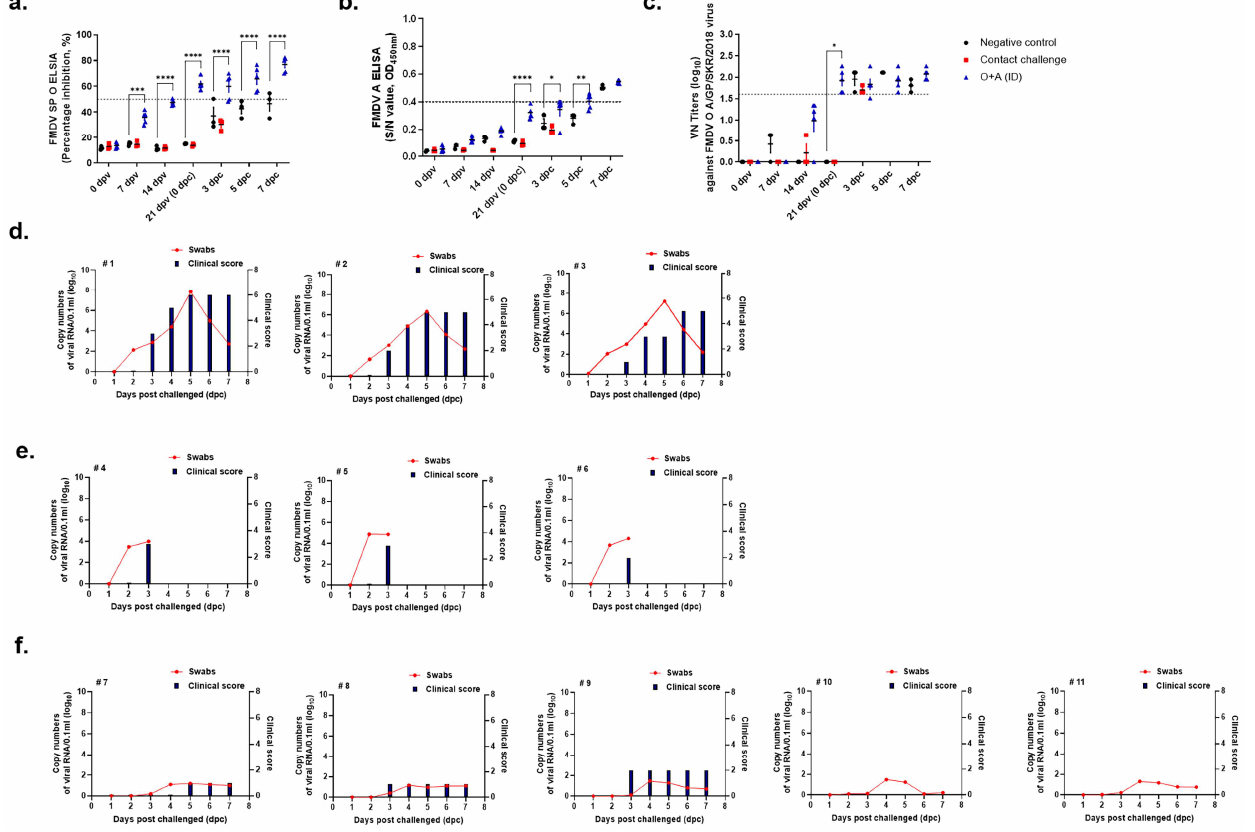
Figure 5. Clinical scores and FMDV RNA levels in swine immunized and VN titer after contact infection with donor swine inoculated with the A/GP/SKR/2018 strain. After vaccination, the swine were challenged with the A/GP/SKR/2018 strain. FMD virus RNA levels in nasal swabs were measured by qRT-PCR from 0 to 7 days after challenge. Serum samples from the swine at 0, 7, 14, and 21 dpv, and 0, 3, 5, and 7 dpc were analyzed via VN test. ( a ) Percentage inhibition (PI) value of type O SP ELISA in individuals. ( b ) Percentage inhibition (PI) value of type A SP ELISA in individuals. ( c ) VN titers against O/SA/SKR/2019 strain. ( d ) The clinical scores and FMD virus RNA levels in negative group. ( e ) The clinical scores and FMD virus RNA levels in contact infection group. ( f ) The clinical scores and FMD virus RNA levels in ID vaccination group. ID: intradermal injection; the datasheets are the mean ± SEM; statistical analyses were performed using two-way ANOVA; *, p < 0.05; **, p < 0.01; ***, p < 0.001; and ****, p <